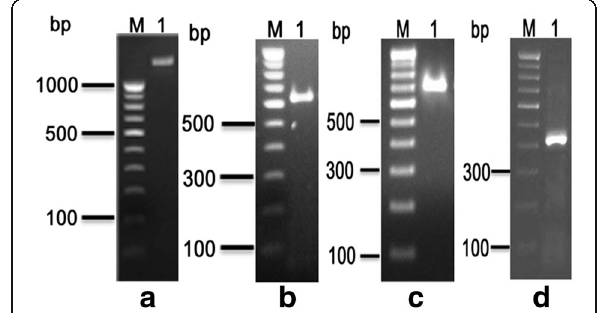
Fig. 2 PCR detection of lipopeptide biosurfactant and β -1,3-glucanase